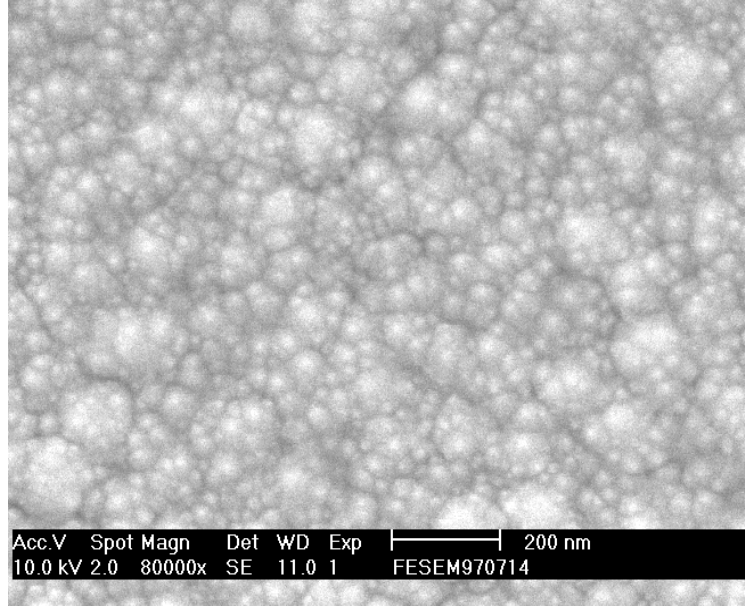
Figure 3. Nanometric structures of ruthenium nitride thin films by SEM